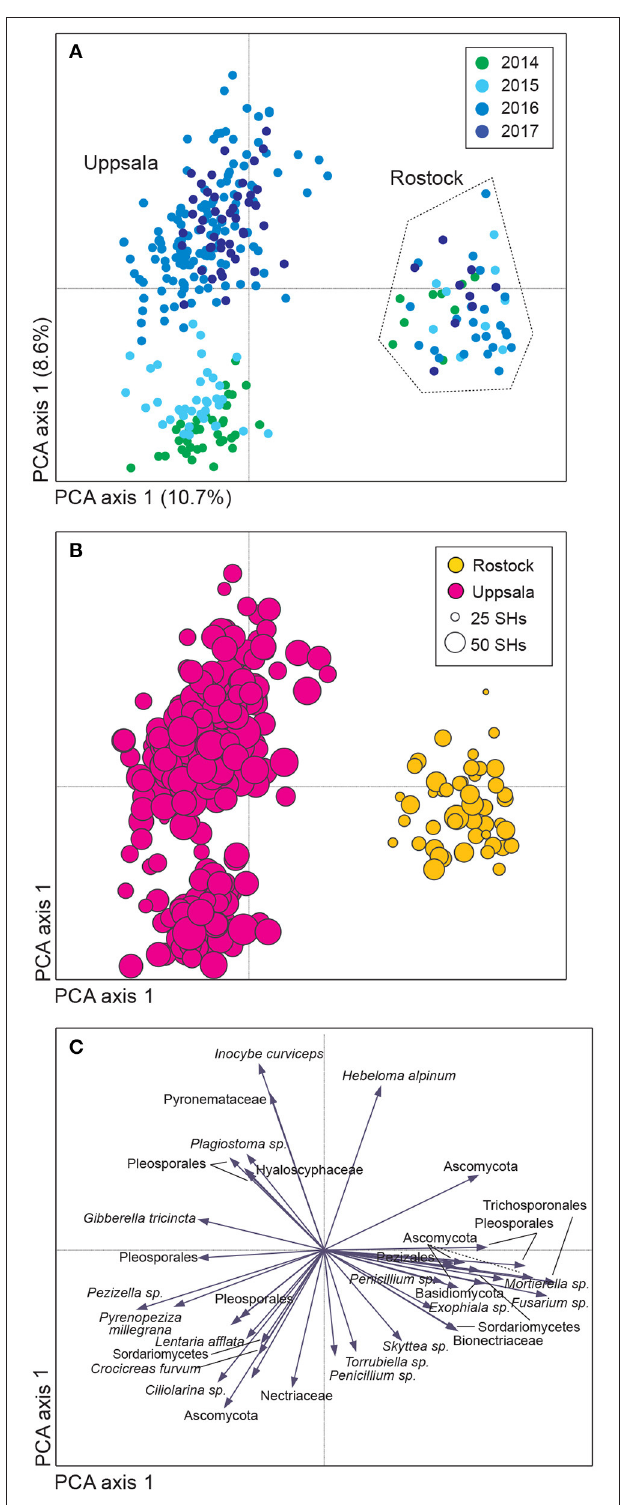
FIGURE 1 | Variation in soil fungal community composition in Salix genotype trials with the four genotypes “Björn,” “Jorr,” “Loden,” and “Tora” planted in monoculture and various genotype mixtures (2-, 3-, and 4-mixtures) at two different sites (Rostock, Germany, and Uppsala, Sweden).